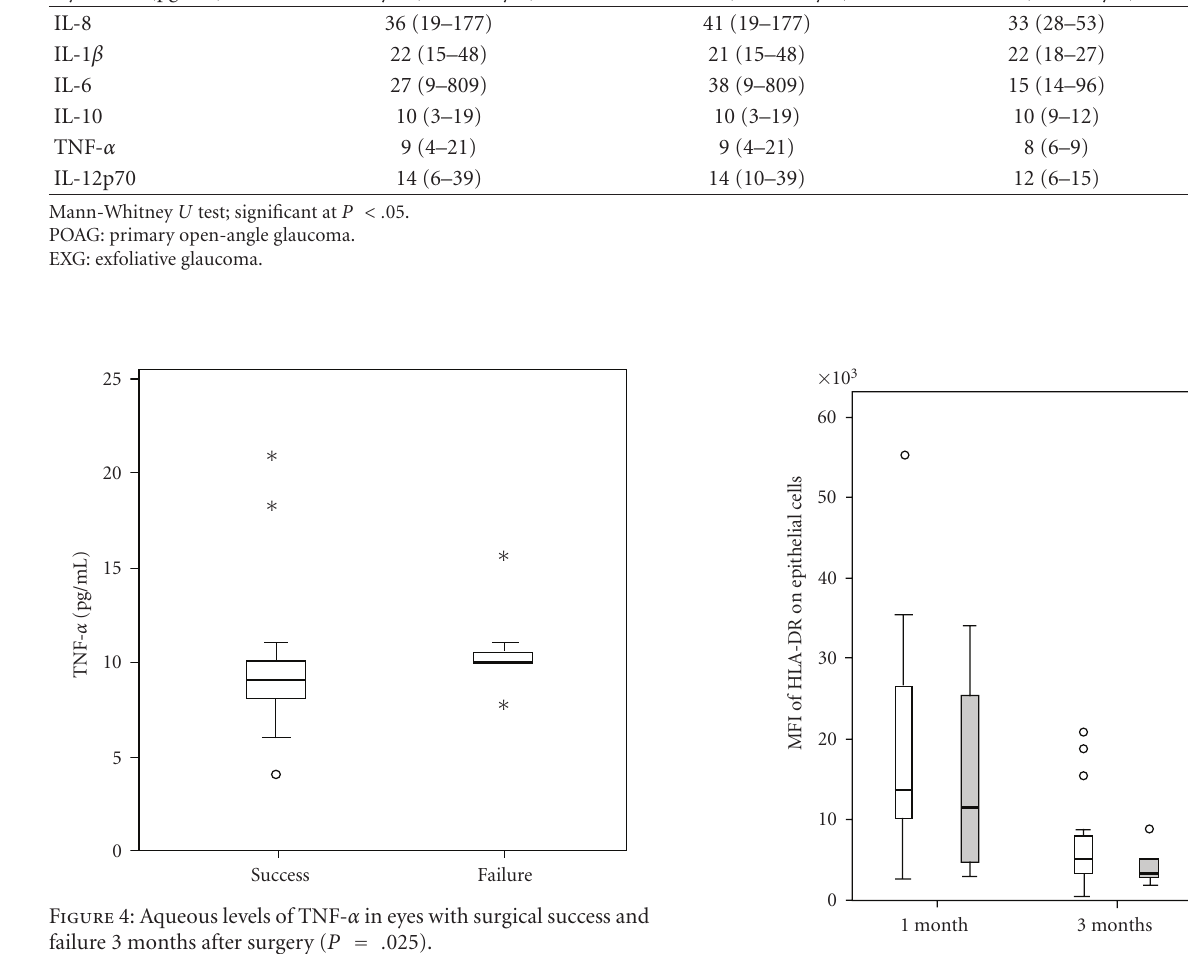
Table 1: Median levels of cytokines (ranges) in the aqueous humour of 30 eyes (30 patients) and with respect to the type of glaucoma. Cytokines (pg/mL)